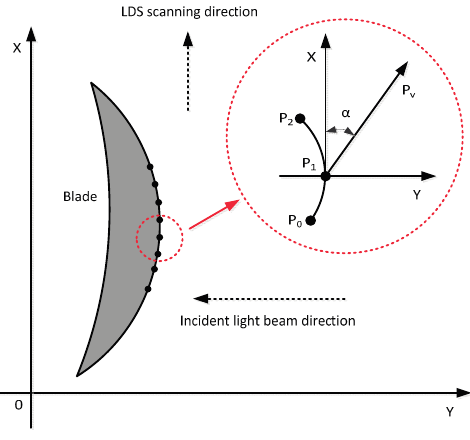
Figure 14. Planning and measuring point blade pitch angle calculation